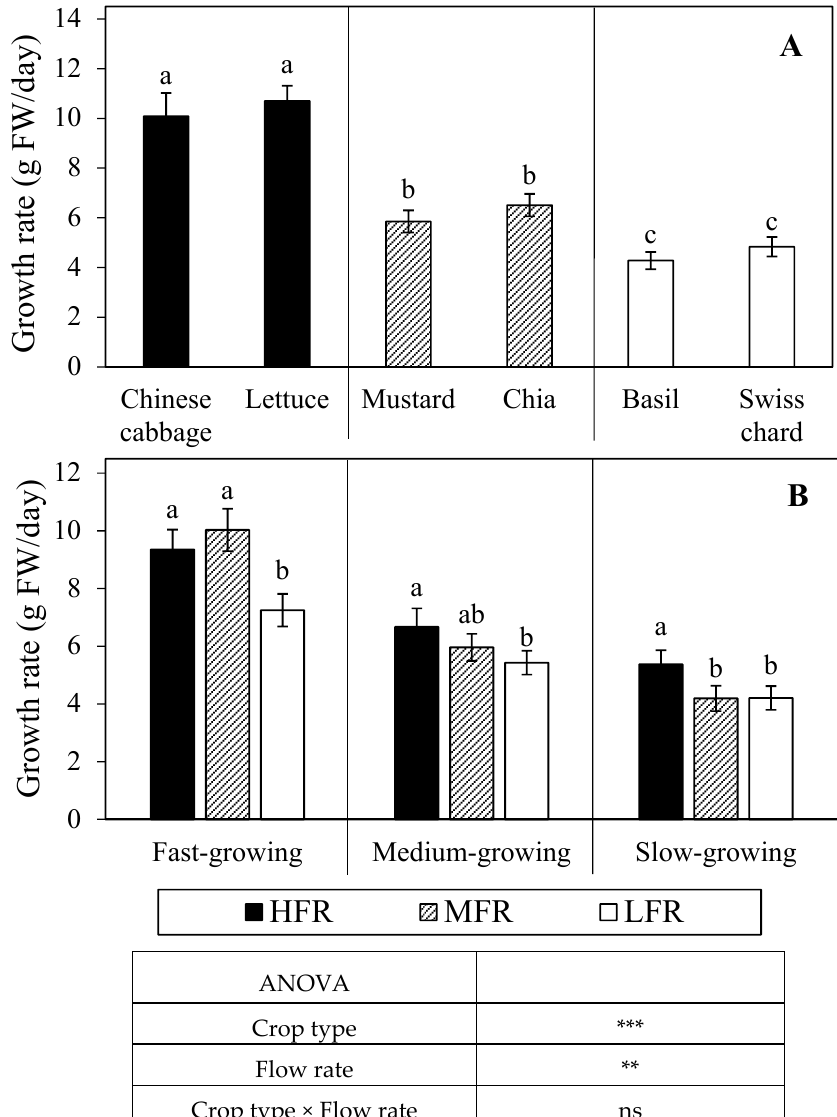
Figure 5. ( A ) Daily growth rate of fast ‐ growing (Chinese cabbage, lettuce), medium ‐ growing (mustard, chia), and slow ‐ growing (basil, Swiss chard) crops in aquaponics and ( B ) their growth rate as affected by high (HFR, 3.3 m/day), medium (MFR, 2.2 m/day), and low (LFR, 1.1 m/day) flow rate. The same letter ( A ) across all species and ( B ) within the same crop type is not significantly different based on Tukey’s honestly significant difference test ( α = 0.05). Data represent the mean of ( A ) 16 replicates ± SE and ( B ) 32 replicates ± SE. ns, *, **, *** mean no significant or significant differences at p ≤ 0.05, 0.01, or 0.001, respectively.